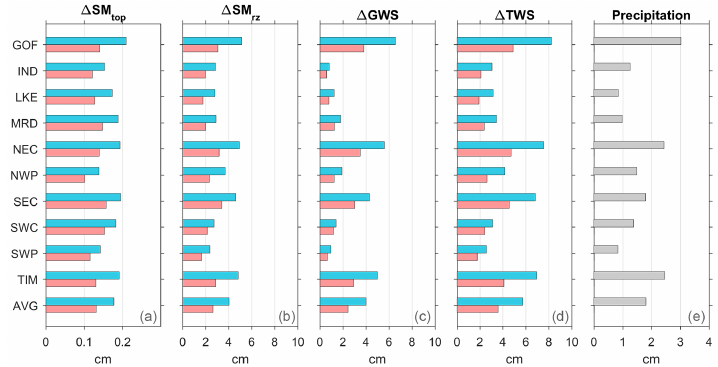
Figure 8. Uncertainties in (cid:49) SM top , (cid:49) SM rz , (cid:49) GWS, and (cid:49) TWS estimated from the model (blue) and the GC solutions (red) in 10 different Australian basins. The uncertainty in the precipitation is shown in (e) . The area-weighted average value (AVG) is also shown.